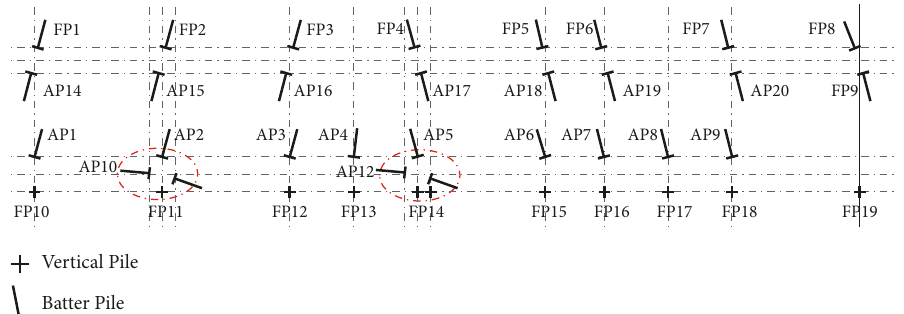
Figure 15: Pile orientation plan of the auxiliary working ship berth of an LNG wharf in the south port area of the Tianjin Port.